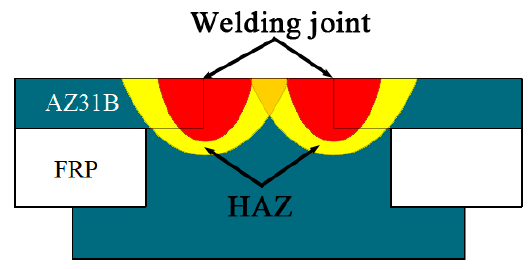
Figure 7. The diagram of the bonding structure of the joint.